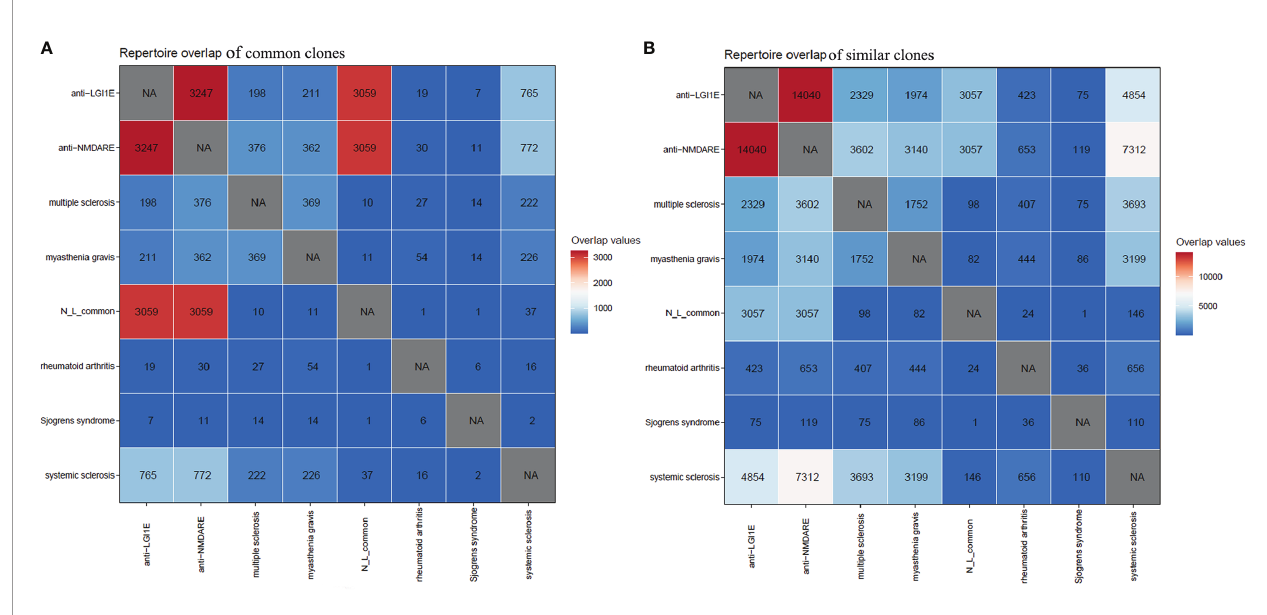
FIGURE 5 | Common and similar clones among patients with anti-NMDARE, anti-LGI1E, myasthenia gravis, multiple sclerosis, rheumatoid arthritis, systemic sclerosis, and Sjögren ’ s syndrome. (A) The distribution of common clones in each group. (B) The distribution of similar clones in each group. Anti-NMDARE, anti-N- methyl-D-aspartate receptor encephalitis; anti-LGI1E, anti-leucine-rich glioma-inactivated 1 encephalitis; N_L_common, common clones shared by the anti-NMDARE and anti-LGI1E groups. NA, not